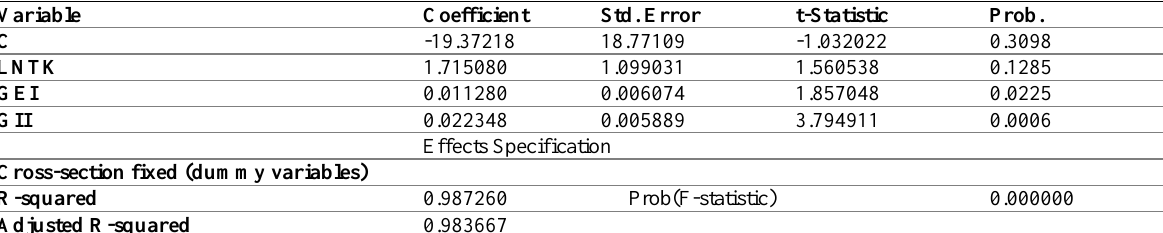
Table 3: Fix Effect Model Result